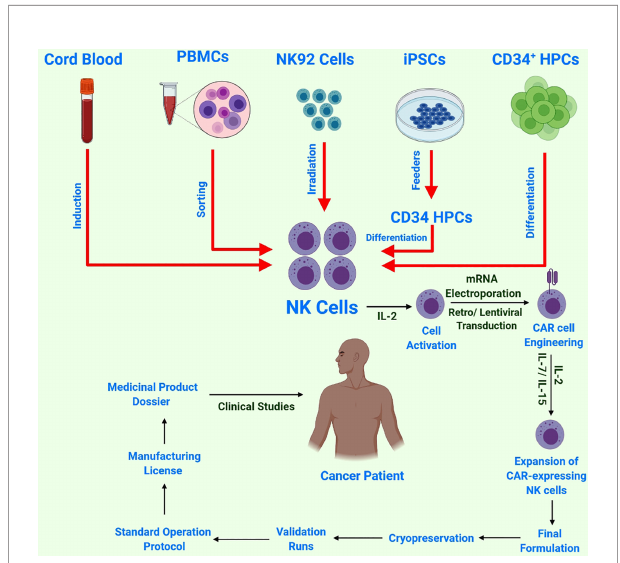
FIGURE 3 | SchematicofNKcellsourcesandCAR-NKcell/immunetherapy work fl ow:NKcellsharvestedfrommultiplesources,followedbyNK-cellactivation byIL-2andsubsequenttransductionwithaconstructencodingCAR.Next,these reprogrammedCAR-NKcellsareexpanded ex-vivo